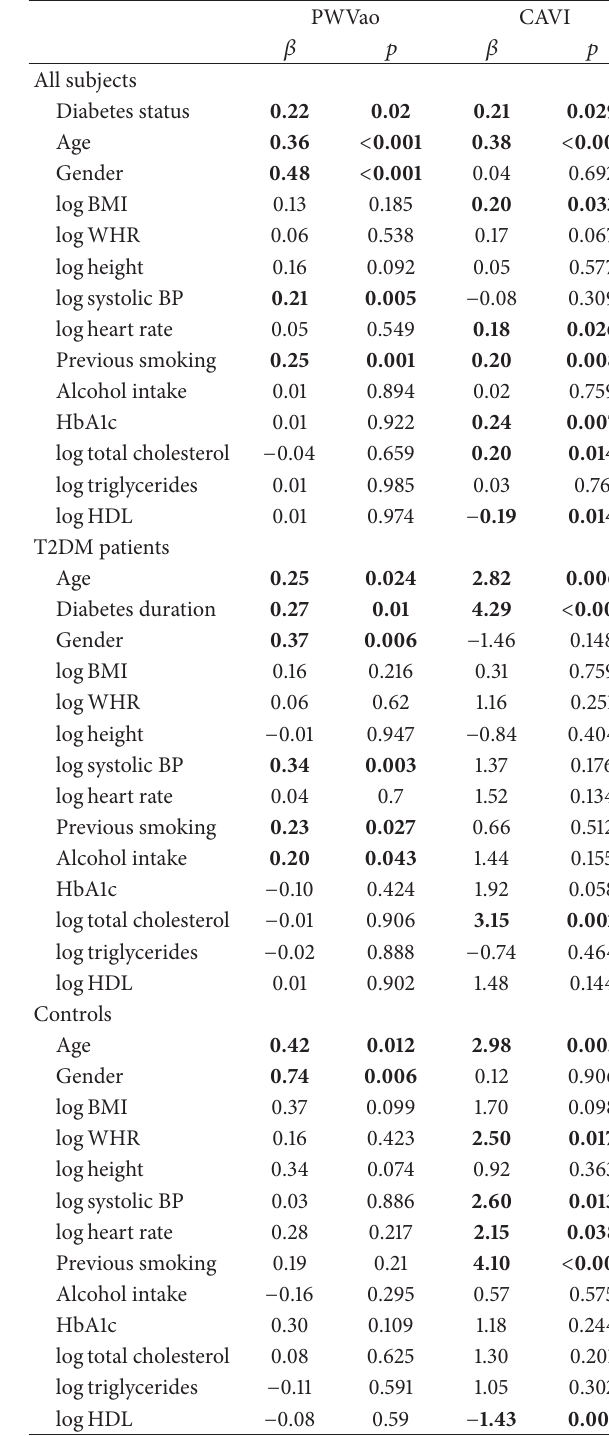
Table 1: Clinical characteristics of study subjects. Table 2: Multiple regression analysis between patients’ characteris- tics versus PWVao and